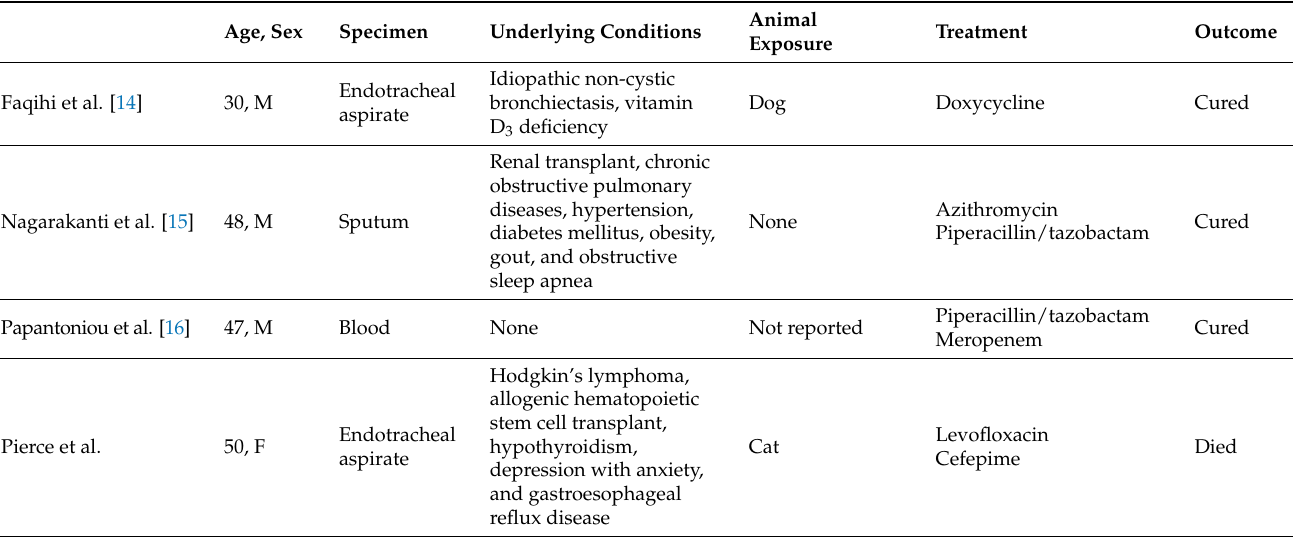
Table 2. Clinical characteristics of patients with COVID-19 and Bordetella bronchiseptica